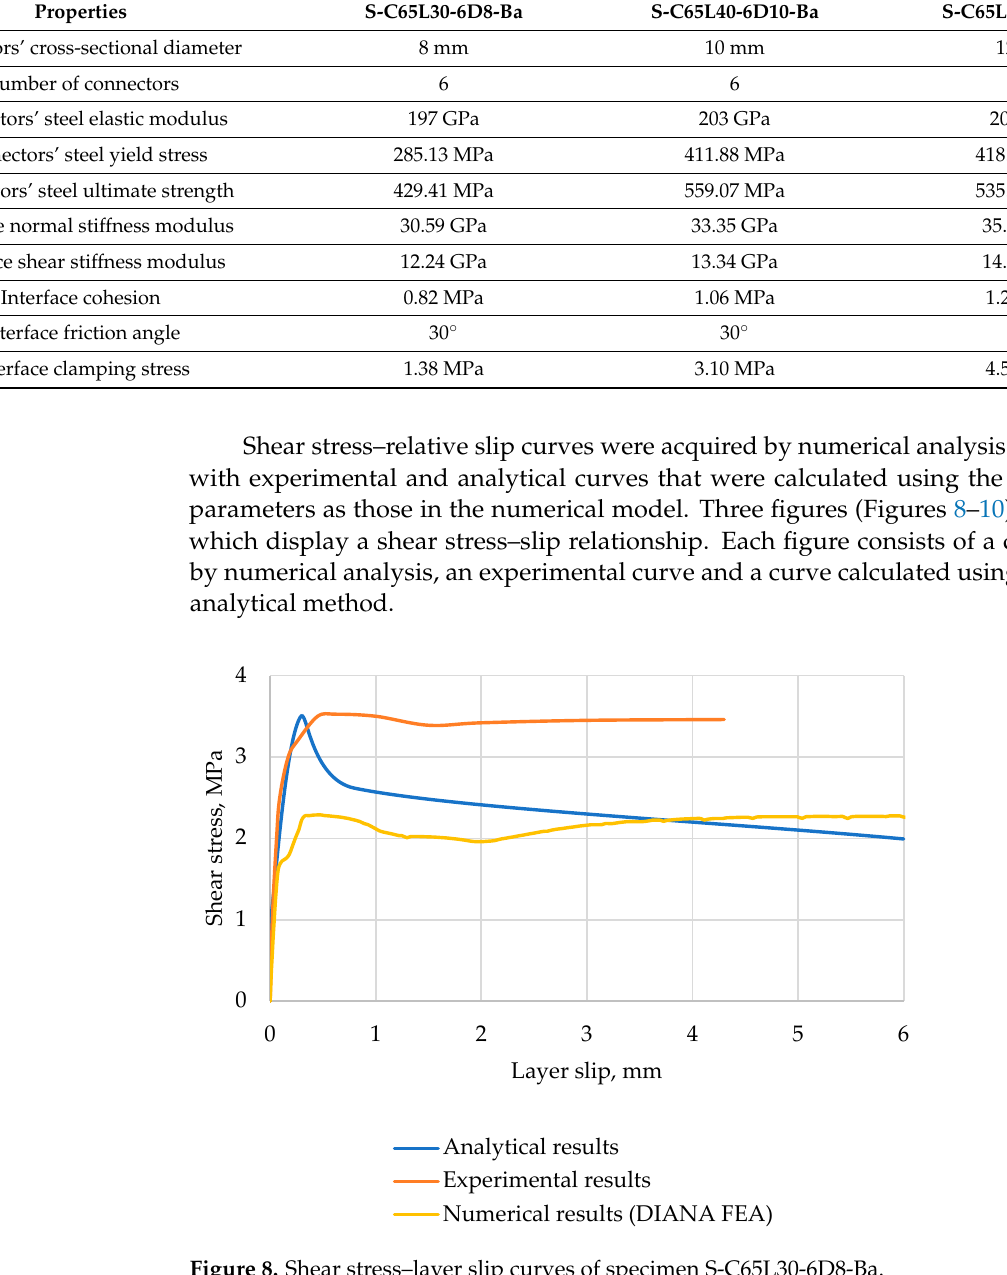
Figure 9. Shear stress–layer slip curves of specimen S-C65L40-6D10-Ba.